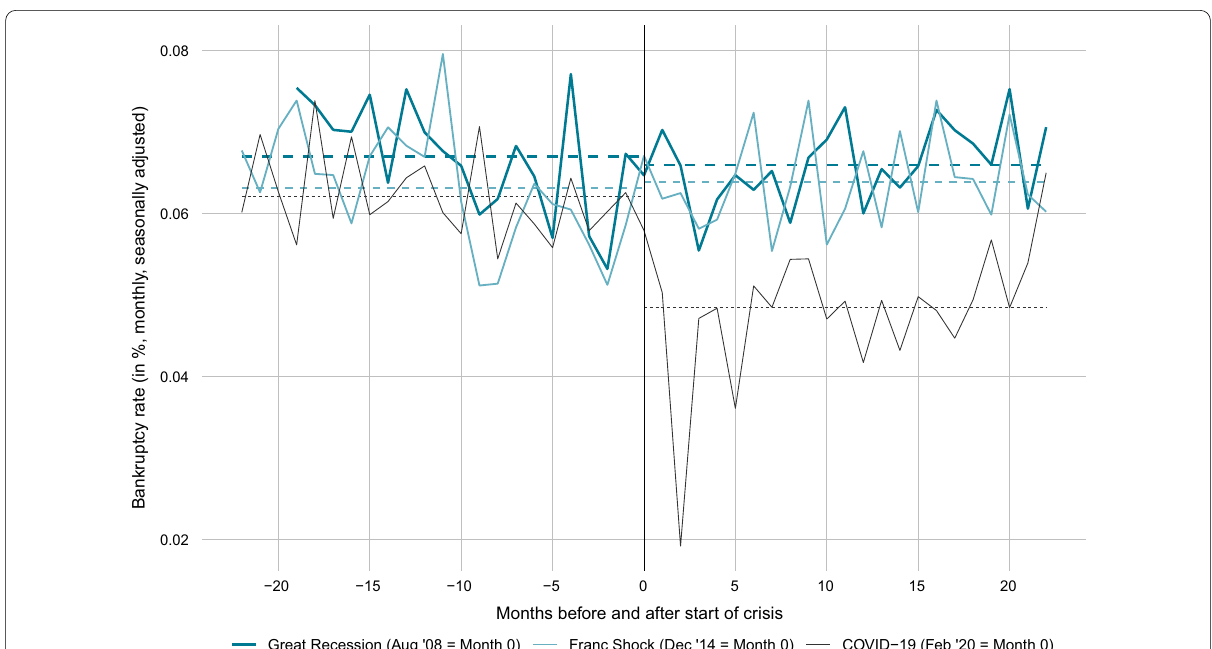
Fig. 4 Comparison of bankruptcy rates before and after crisis periods. Notes : The figure shows the monthly bankruptcy rate ( adjusted frequency of total firm bankrupcties excluding SCO Art. 731b cases divided by the total stock of firms) in Switzerland before and after the start of the Great Recession, the Swiss Franc Shock and the COVID-19 crisis. Month 0 is the last month before the crisis start. The dotted lines are the average bankruptcy rates over the 22 months before or after the respective crisis start